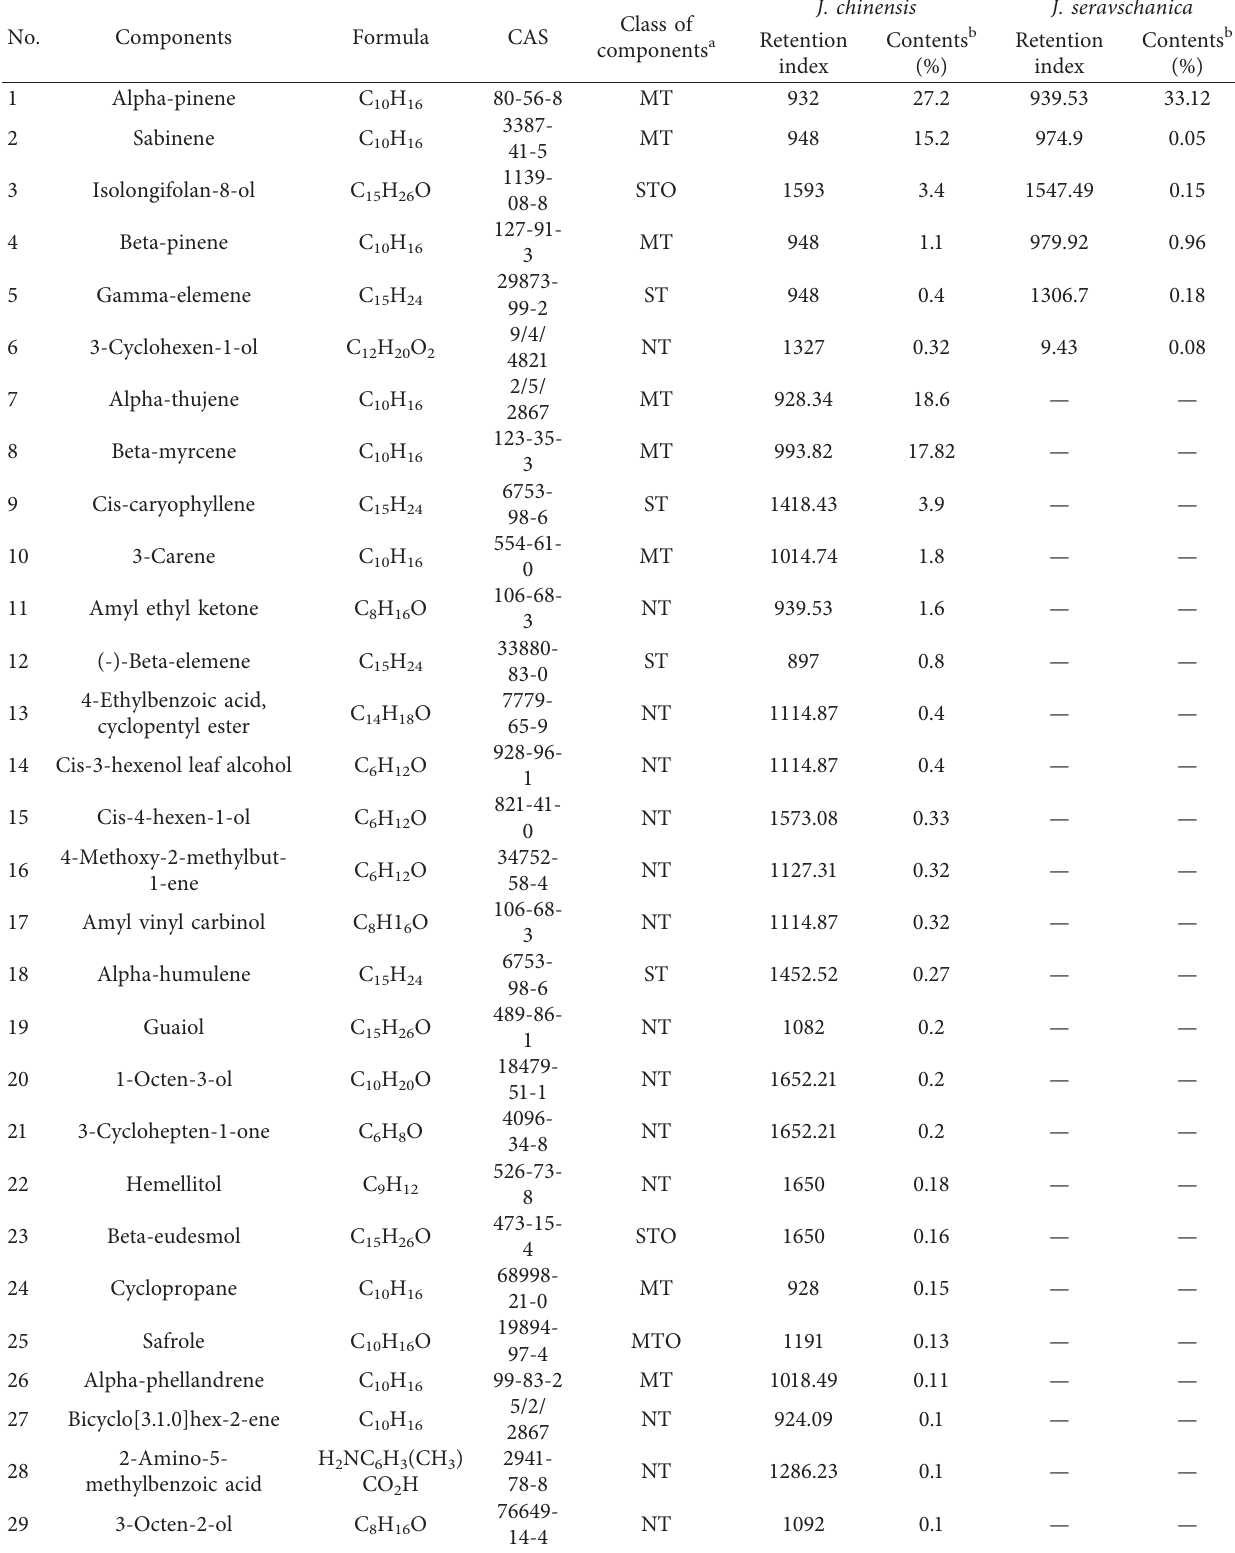
Table 1: Chemical composition of the essential oils extracted from the leaves of J. chinensis and J. seravschanica analysed using the HS- SPME-GCMS